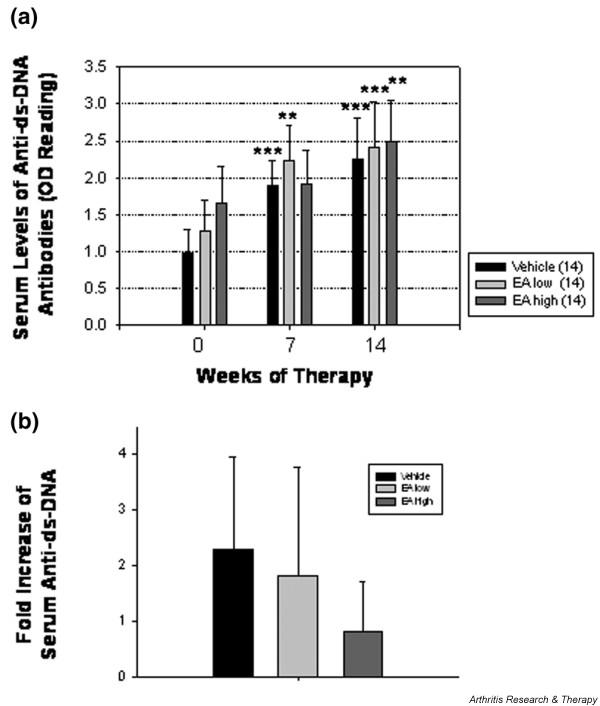
Serum anti-double-stranded (ds)DNA antibody in the NZB/WF1 mice before and after treatment with vehicle or the ethyl acetate (EA) extract of Tripterygium wilfordii Hook F. (a) Serum was collected before, 7 and 14 weeks after starting treatment. Anti-dsDNA antibody was determined by ELISA as described in Materials and methods. The mean of relative titers of anti-dsDNA antibody of serum obtained from normal C57BL/6j mice was 0.23 (0.1 to 0.3). Numbers in parentheses indicate the mice evaluated. Data are the mean ± standard error of the mean of the optical density (OD) readings on 1:20 diluted serum of each group. **p < 0.01, ***p < 0.001 at time 0 versus at 7 weeks or 14 weeks of treatment for the same group. (b) The same data were analyzed as the change in anti-dsDNA antibody titers from the baseline at 28 weeks of age. Original magnification × 400.